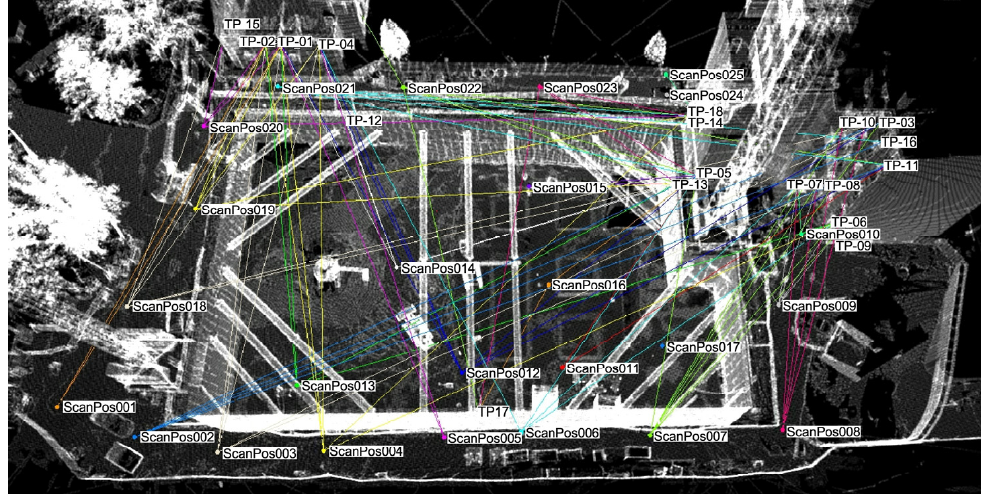
Figure 6. Registration and mutual alignment of point clouds with visible directions to tie points.